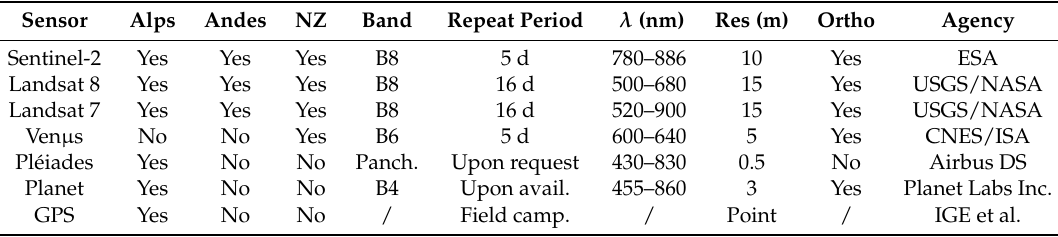
Table 1. Summary of satellite and ground observations used for the Andes, Alps and New-Zealand (NZ) along with technical information. Repeat period defines the satellite acquisition frequency, λ is the wavelength in nanometers, Res is the pixel resolution in meters, Ortho indicates if orthorectified images are